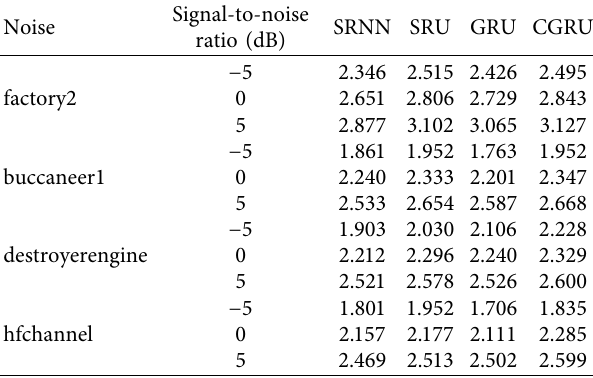
Table 1: Average Perceptual Evaluation of Speech Quality (PESQ).